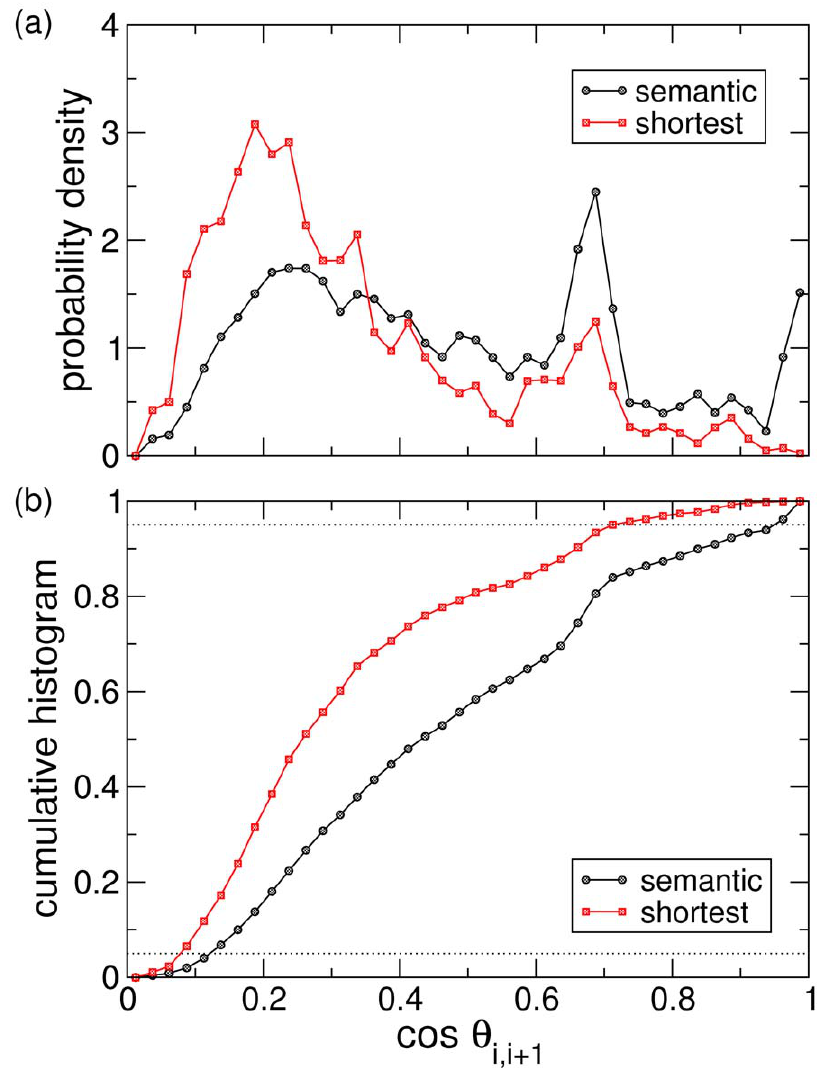
Figure 6. (a) Probability density of similarities between consecutive nodes along all semantic (black circles) and shortest paths (red squares). Semantic paths exhibit a peak around 0 : 7 , whereas the mode of the distribution for shortest paths is peaked around 0 : 2 . This fact shows that similarity between consecutive jumps from source to target along semantic paths is smooth, whereas similarity can change abruptly along shortest paths. (b) Cumulative probability of similarities between consecutive nodes. Note that the distribution for semantic paths lays below the shortest paths’ one. Dotted lines mark the 0 : 05 and 0 : 95 probability levels.